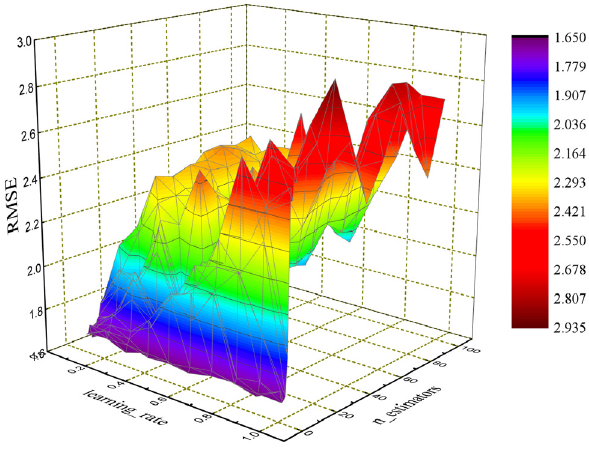
Figure 8: The variety of RMSE with learning_rate and n _estimators in optimizing LR - AdaBoost ’ s hyperparameters.